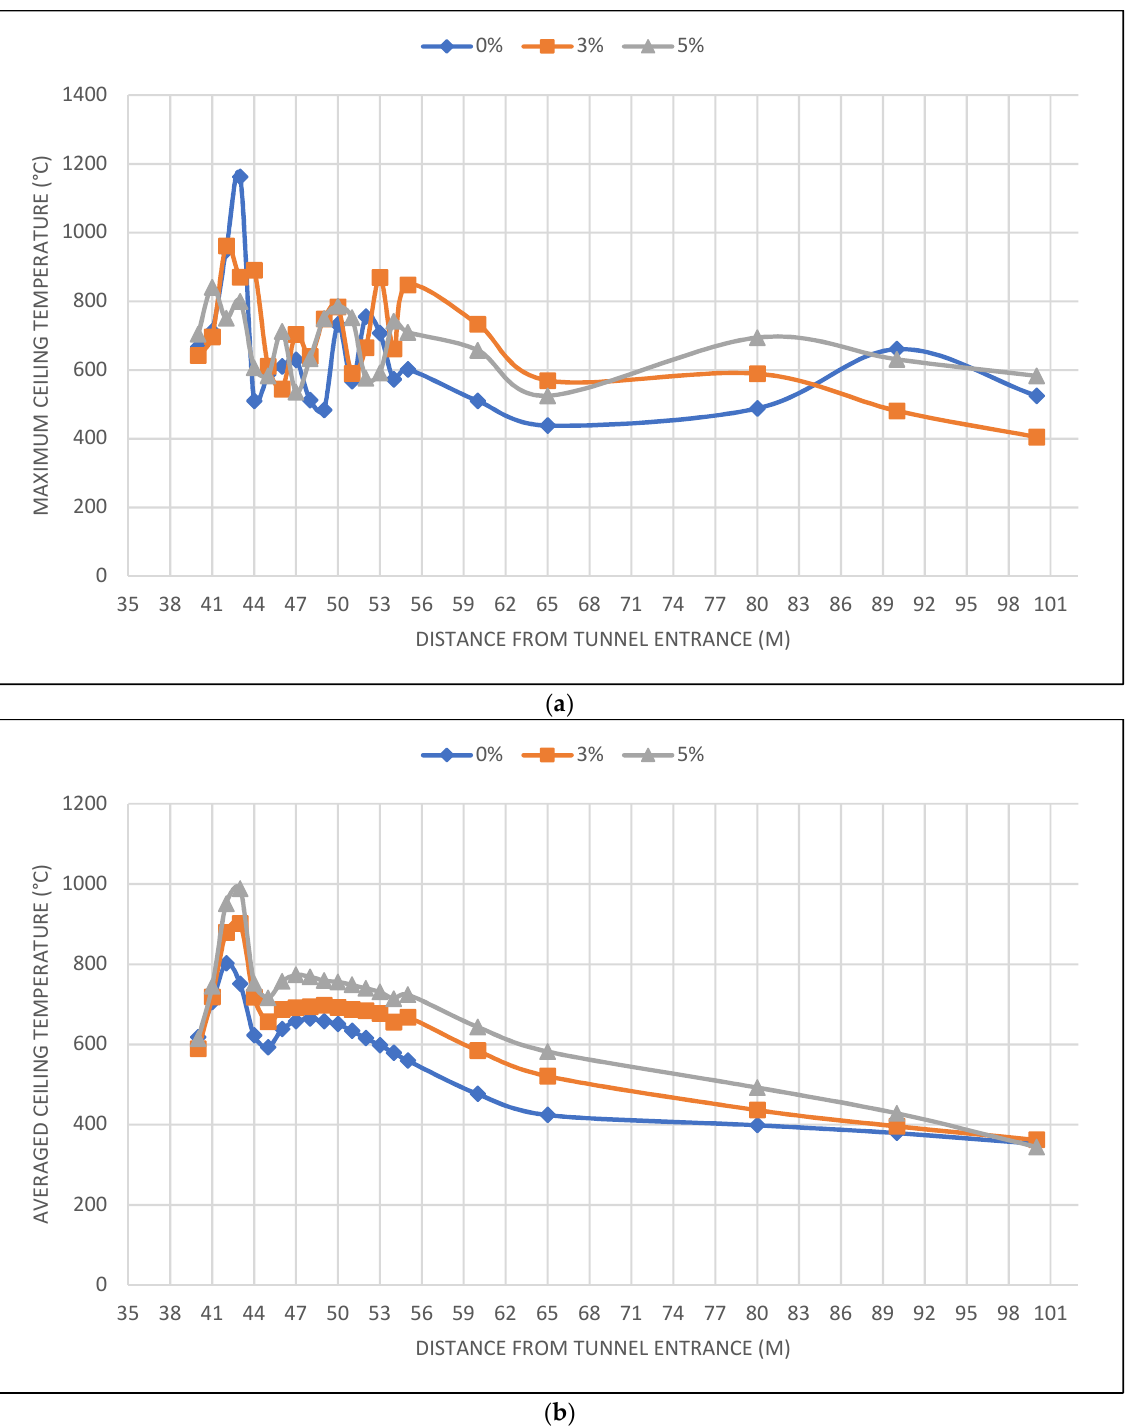
Figure 6. ( a ) Maximum ceiling temperatures and ( b ) Averaged ceiling temperatures along the tunnel at V L = 2.5 m/s, V T = 0 m/s—effect of tunnel slope (Cases 2, 8 and